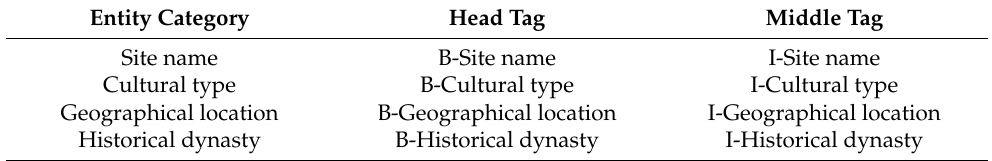
Table 1. Archaeological entity tag